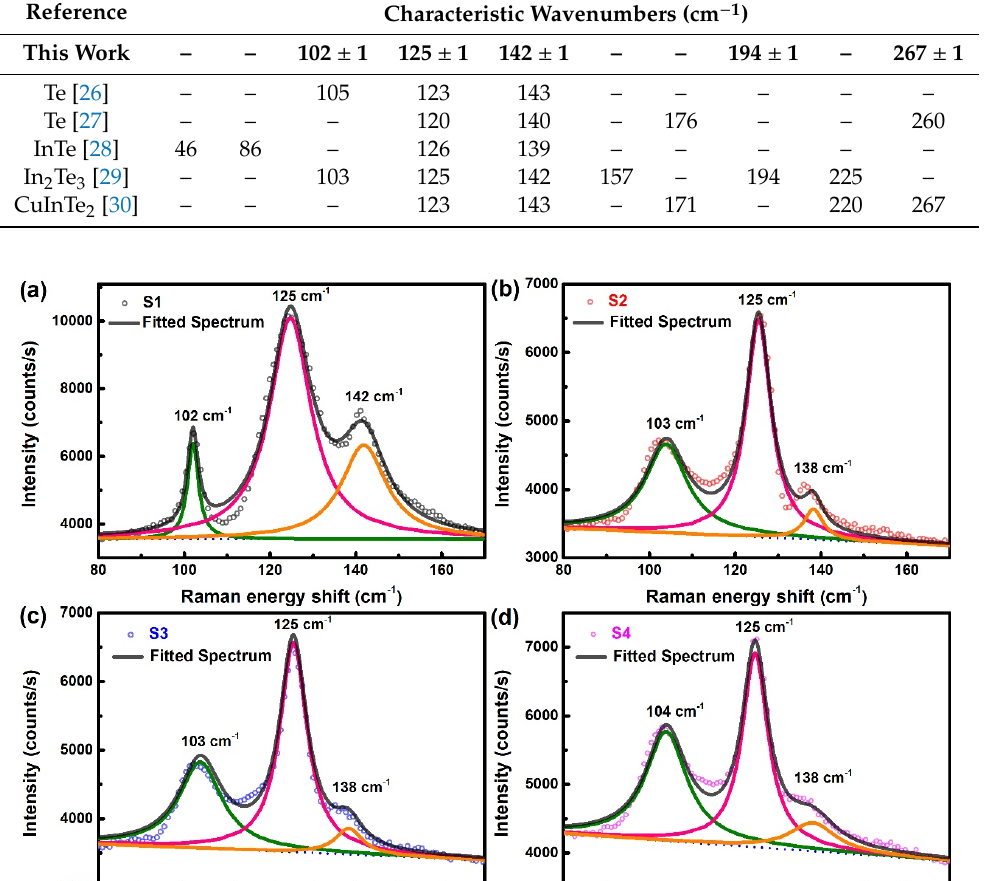
Figure 3. The peak fitting Raman spectra of Ta-doped InTe thin films: ( a ) S1, ( b ) S2, ( c ) S3, ( d ) S4